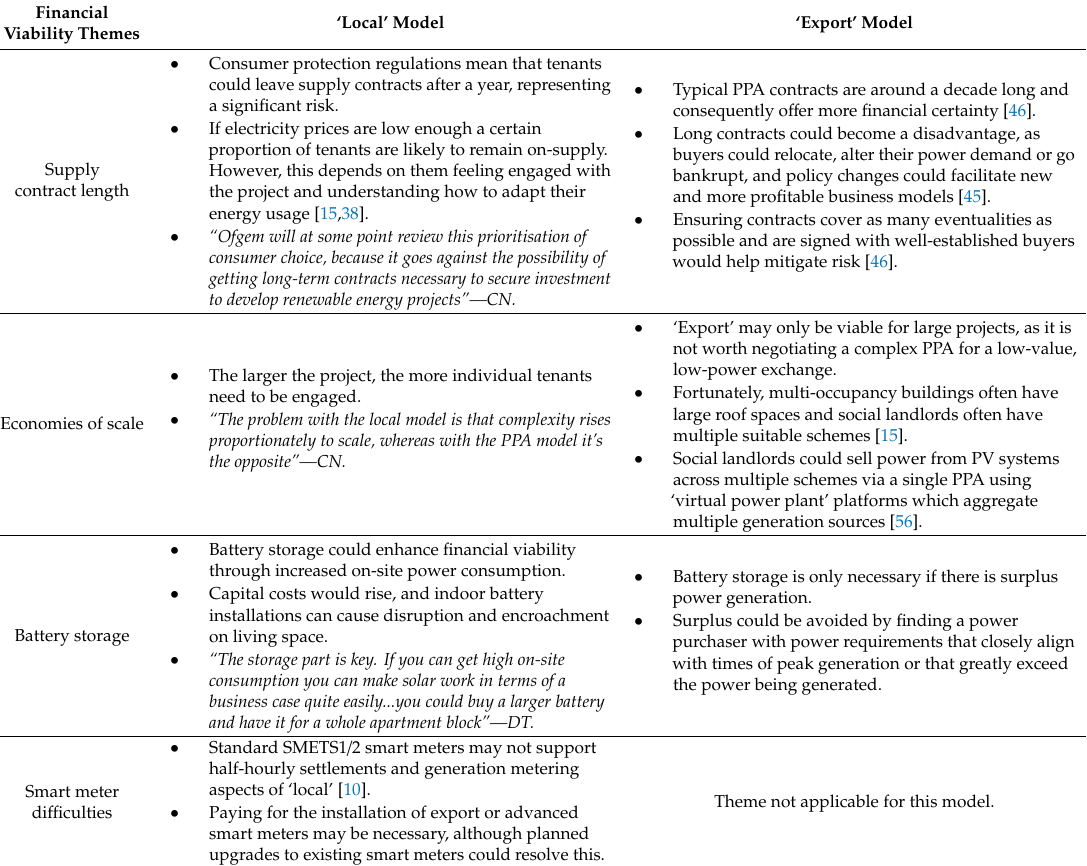
Table 3. Financial viability themes for both models from interview transcript analysis.